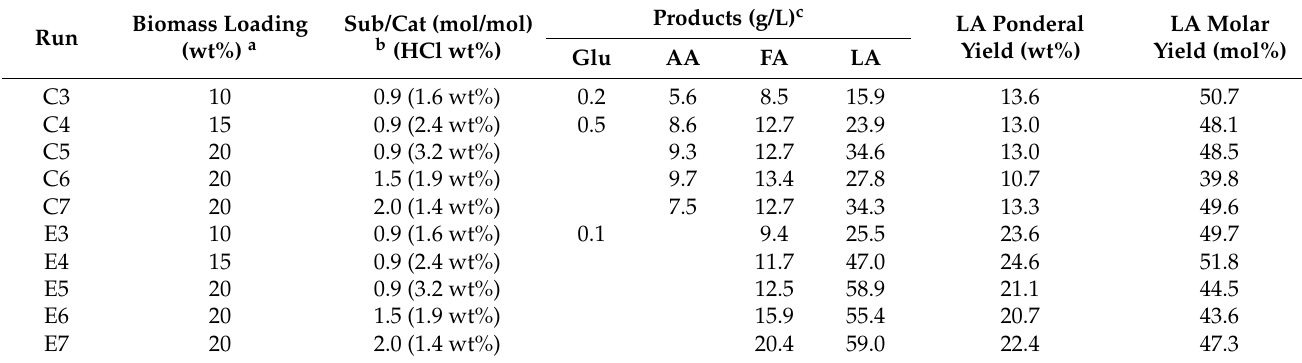
Table 2. Hydrolysis experiments on wet C and E cardoon samples with different biomass loadings and substrate/catalyst molar ratios. Experimental conditions: 190 ◦ C, 20 min, HCl as catalyst, MW